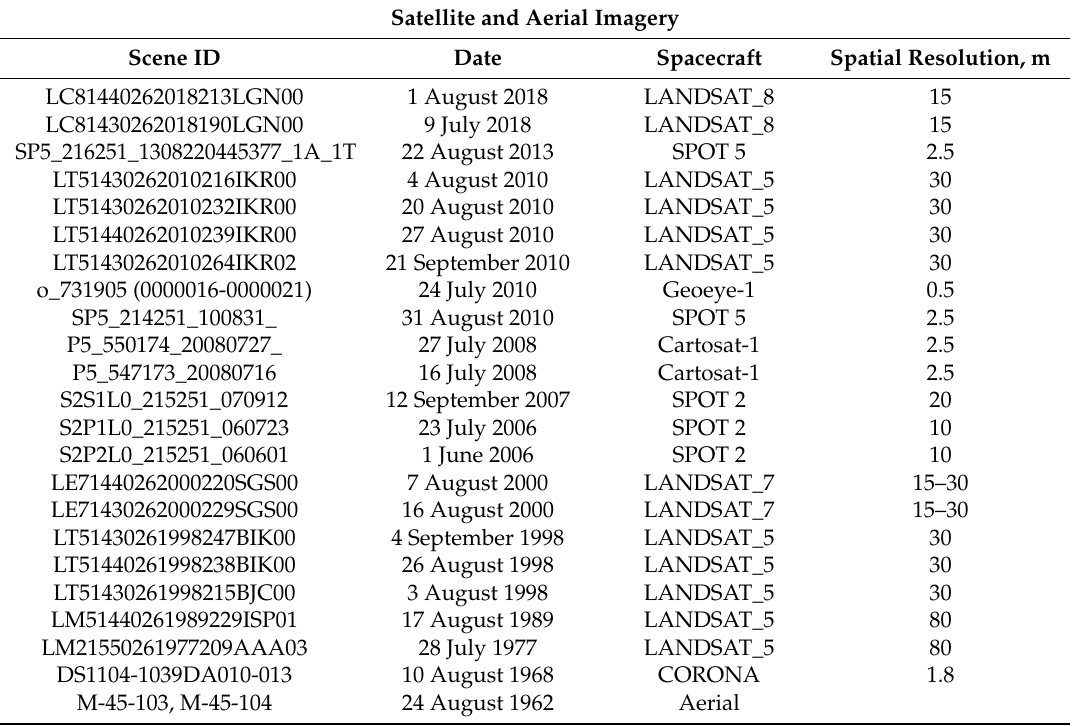
Table 1. Satellite and aerial imagery used in the study of Tavan Bogd